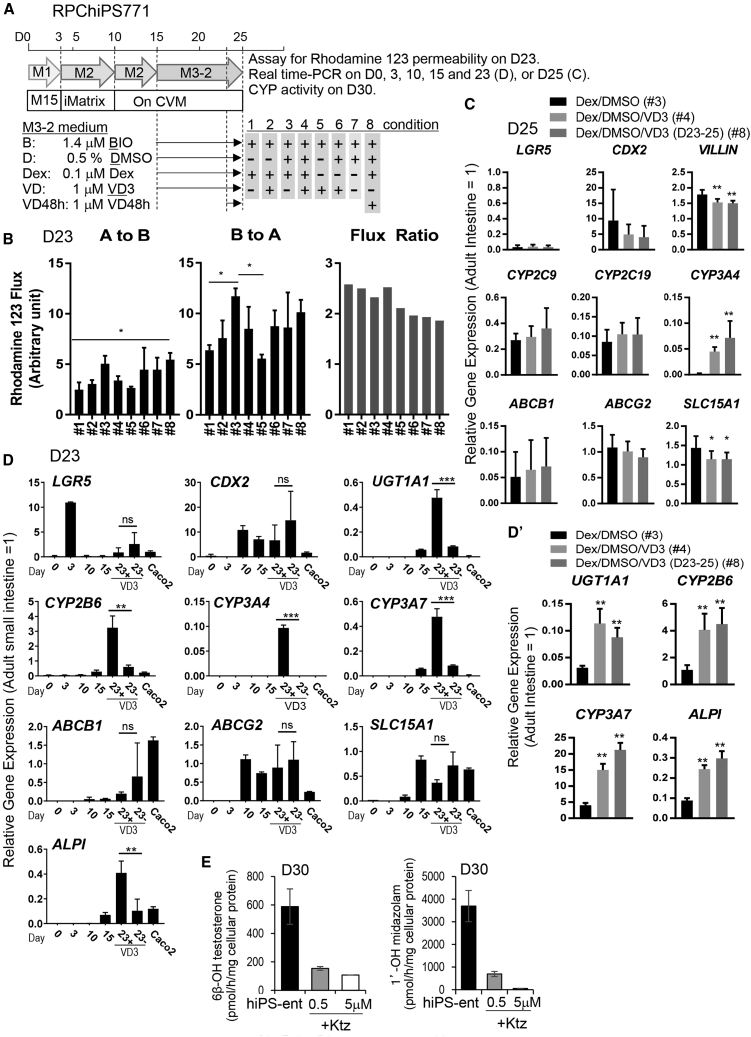
Components for Maturation into hiPSC-derived Enterocyte-Like Cells(A) A schematic drawing of the experimental procedure for differentiating hiPS RPChiPS771 into enterocytes. Maturation was performed by culturing the cells in M3-2, under eight conditions, either with a full set of factors or in the absence of 1 or 2 certain factors, as noted. Differentiated cells were assayed for rhodamine 123 permeability (B), real-time PCR analysis (C, D), and CYP3A activity (E).(B) Directional transcellular transport of fluorescence derived from rhodamine 123 (left: A to B; middle: B to A) or the flux ratio (right) are shown.(C) Expression levels of the gene markers, on maturation under three different conditions (condition #3, 4, 8).(D) Time-dependent expressions of intestinal marker genes (LGR5 and CDX2), metabolic enzymes (UGT1A1, CYP2B6, CYP3A4, and CYP3A7), transporters (ABCB1, ABCG2, and SLC15A1), and a mature marker ALPI, during differentiation and with or without VD3. (D′) Additional experiment was performed to confirm the reproducibility of upregulation of UGT1A1, CYP2V6, CYP3A7, and ALPI expression by VD3.(E) CYP3A4 activity was examined, using testosterone (left) or midazolam (right) as substrates, and quantification of their metabolites was performed by LC-MS/MS. Ktz: ketoconazole (CYP3A inhibitor).Data are expressed as the mean ± SD (n = 3–4; n, independent experiments). (C, D, D′) Relative values versus those of the adult intestine (= 1) are shown. Differences versus controls or between groups were analyzed by one-way ANOVA Tukey's multiple comparisons test (B, C, D′), or Student’s t test between VD3 ± (D); ∗p < 0.05, ∗∗p < 0.01, or ∗∗∗p < 0.001. ns, not significant.